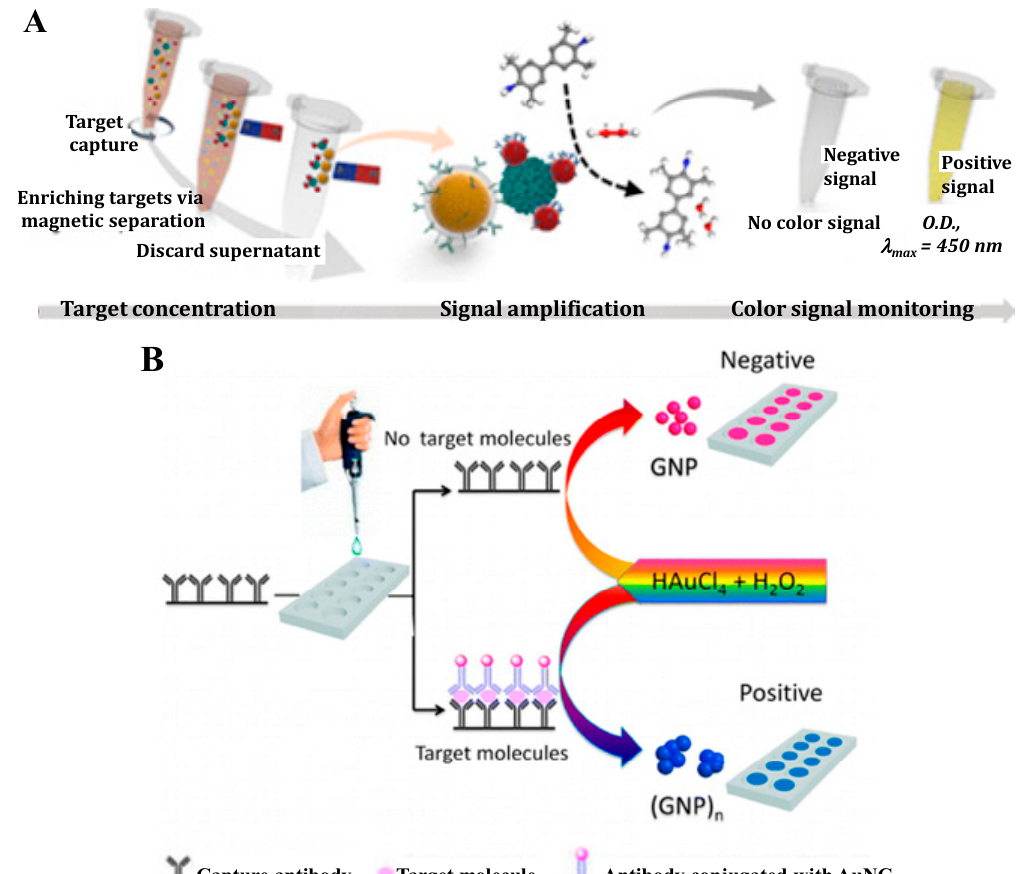
Figure 1. ( A ) Schematic illustration of the magnetic nanobead-based nano(e)zyme-linked immunosorbent assay (MagLISA). Reproduced with permission from [47]. Copyright American Chemical Society, 2018. ( B ) Schematic representation of the plasmonic nanosenor, in which the target molecule is anchored to the substrate by capture antibodies and recognized by other antibodies labeled with gold nanoclusters (AuNCs). Reproduced with permission from [50].